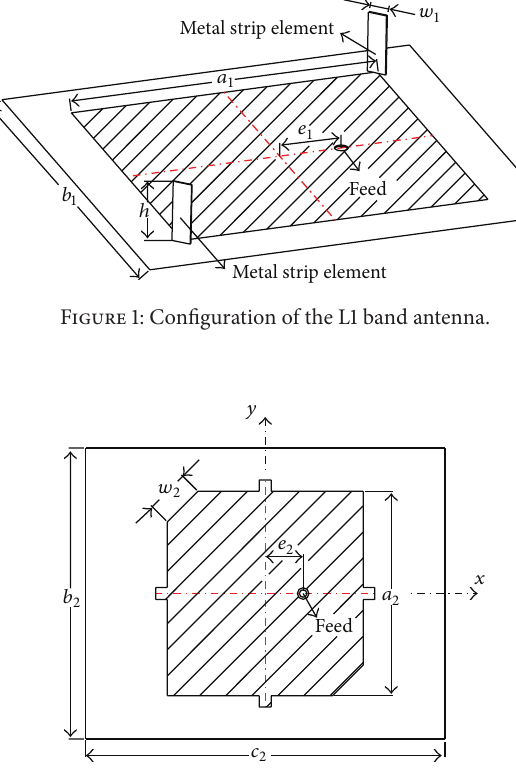
Figure 2: Configuration of the L2 band